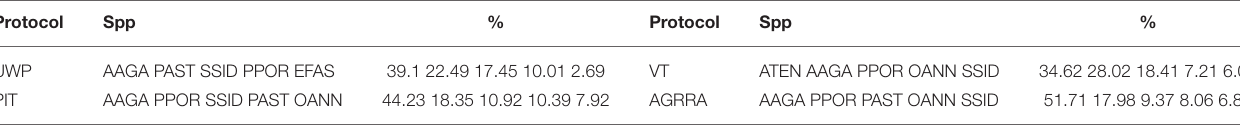
TABLE 2 | Dominant species in terms of abundance, identified with a SIMPER analysis by each sampling design. Protocol Spp % Protocol